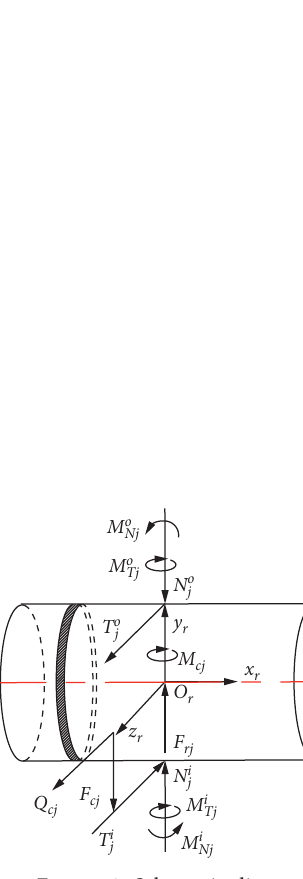
Figure 2: Schematic diagram of roller forces.